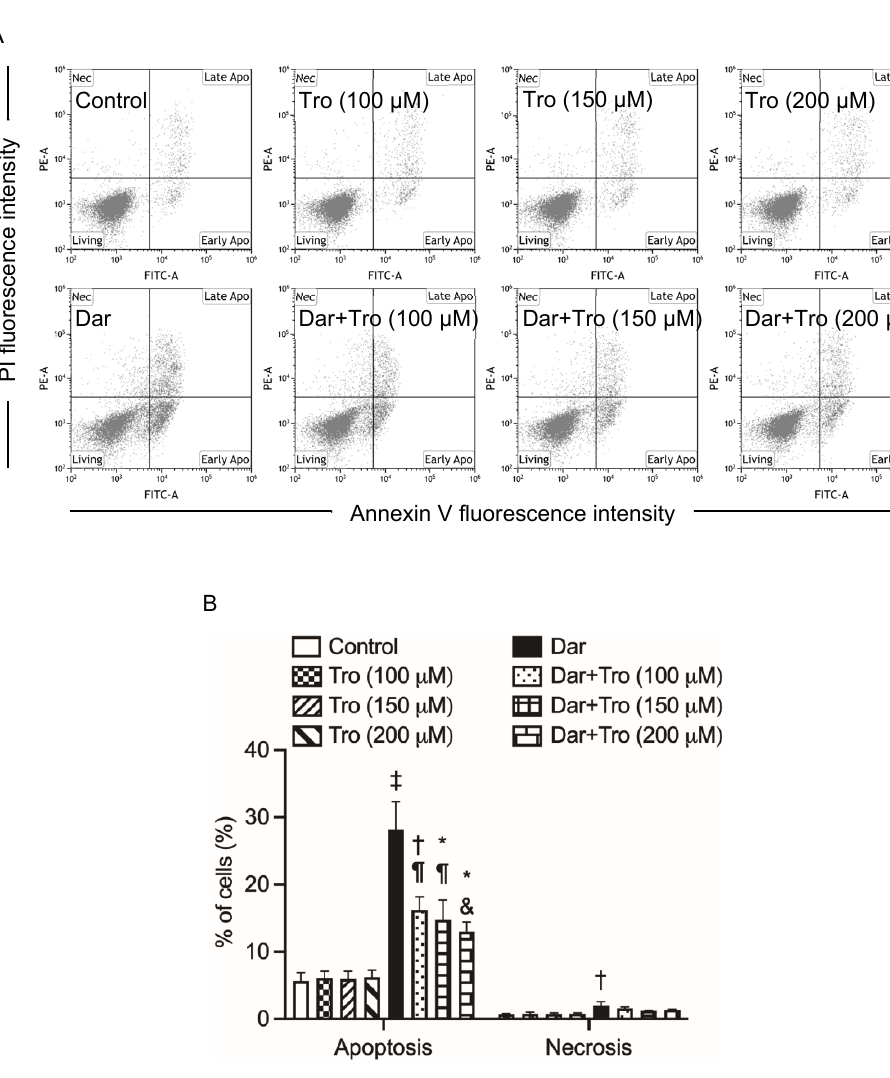
Figure 5. Suppression of darinaparsin-mediated cell death by Trolox in NB4 cells. After treatment for 24 h with 1 µ M darinaparsin in the presence or absence of 100, 150 or 200 µ M Trolox, an antioxidative reagent, cells were stained with annexin V-FITC and PI and analyzed by flow cytometry as described in the legend of Figure 2. Representative flow cytometry dot plots from three independent experiments ( A ), and the quantification in the percentages of apoptotic and necrotic cells ( B ) are shown. Results are shown as the means ± SD from more than three independent experiments. *, p < 0.05; †, p < 0.01; ‡, p < 0.0001 vs. control; ¶, p < 0.01; &, p < 0.001 vs. darinaparsin. Dar, darinaparsin; Tro,